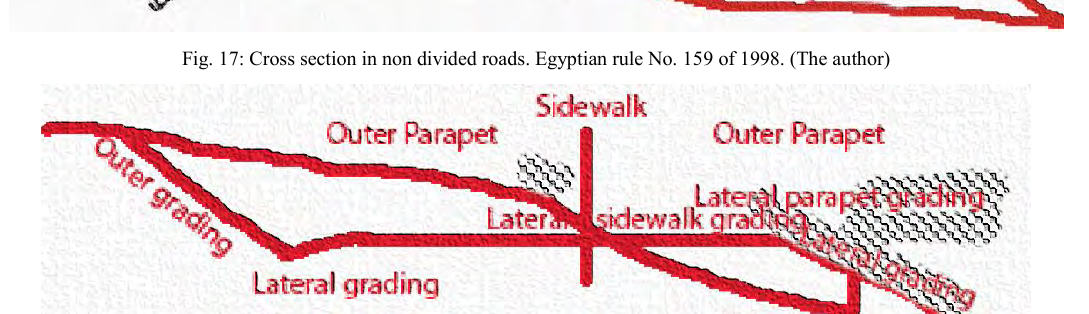
Fig. 17: Cross section in non divided roads. Egyptian rule No. 159 of 1998. (The author)